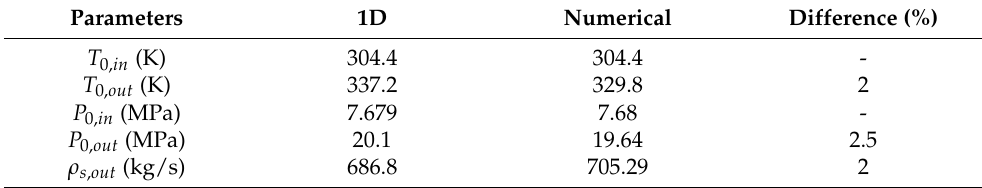
Table 8. Comparison between 1D mean-line and numerical results for validation.